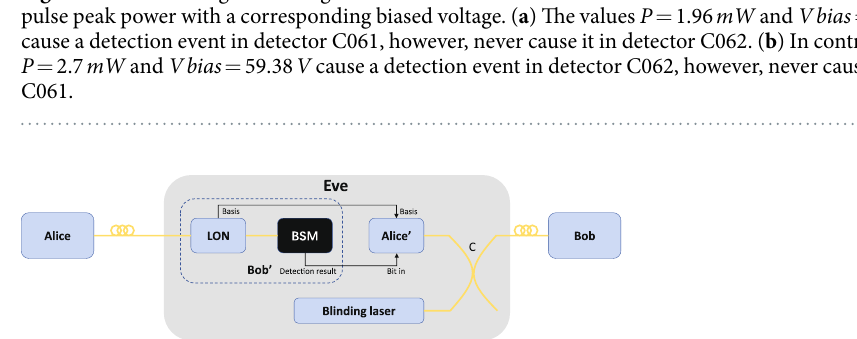
Figure 5. Schematics of hacking scheme. Eve consists of copies of Alice (Alice’) and Bob (Bob’), which share bit and basis settings and a blinding laser. C: optical